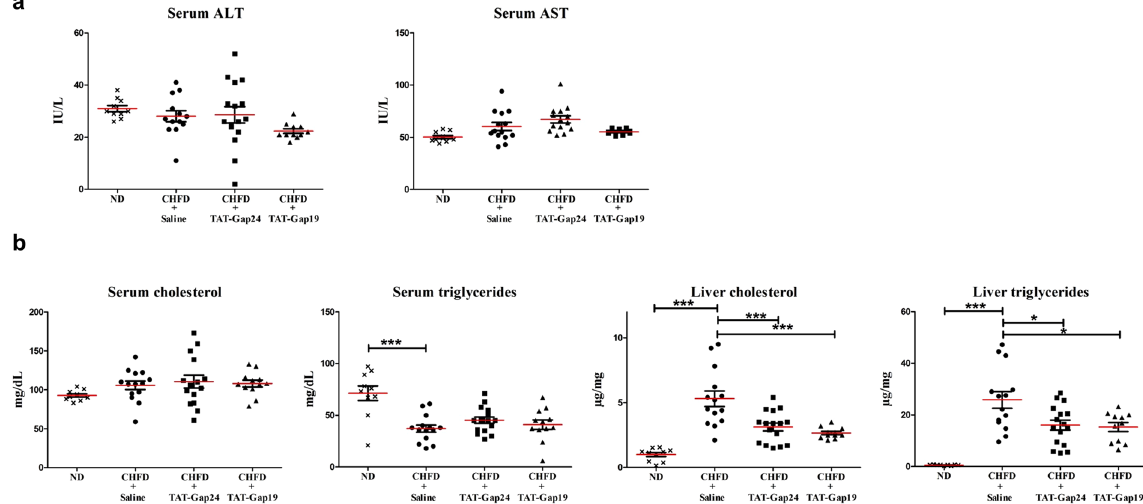
Figure 4. Effects of TAT-Gap24 and TAT-Gap19 on serum transaminases and serum and liver lipid content in NASH. After 8 weeks of CHFD, an osmotic pump was surgically implanted in the abdominal cavity, which ensured sustained release of 1 mg/kg/day TAT-Gap24 (n = 11) or TAT-Gap19 (n = 11) or saline (n = 13)